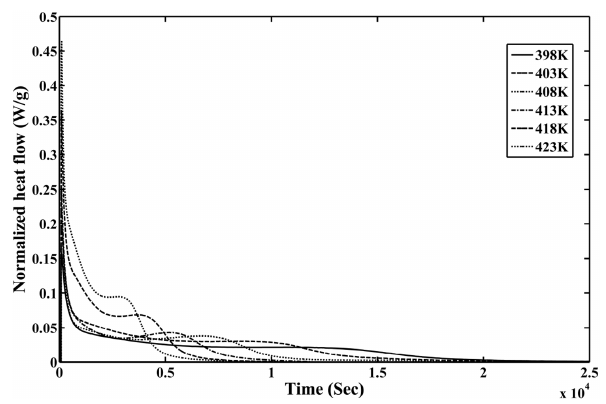
Figure 6: Normalized heat flow from isothermal DSC scan of extracted resin at different